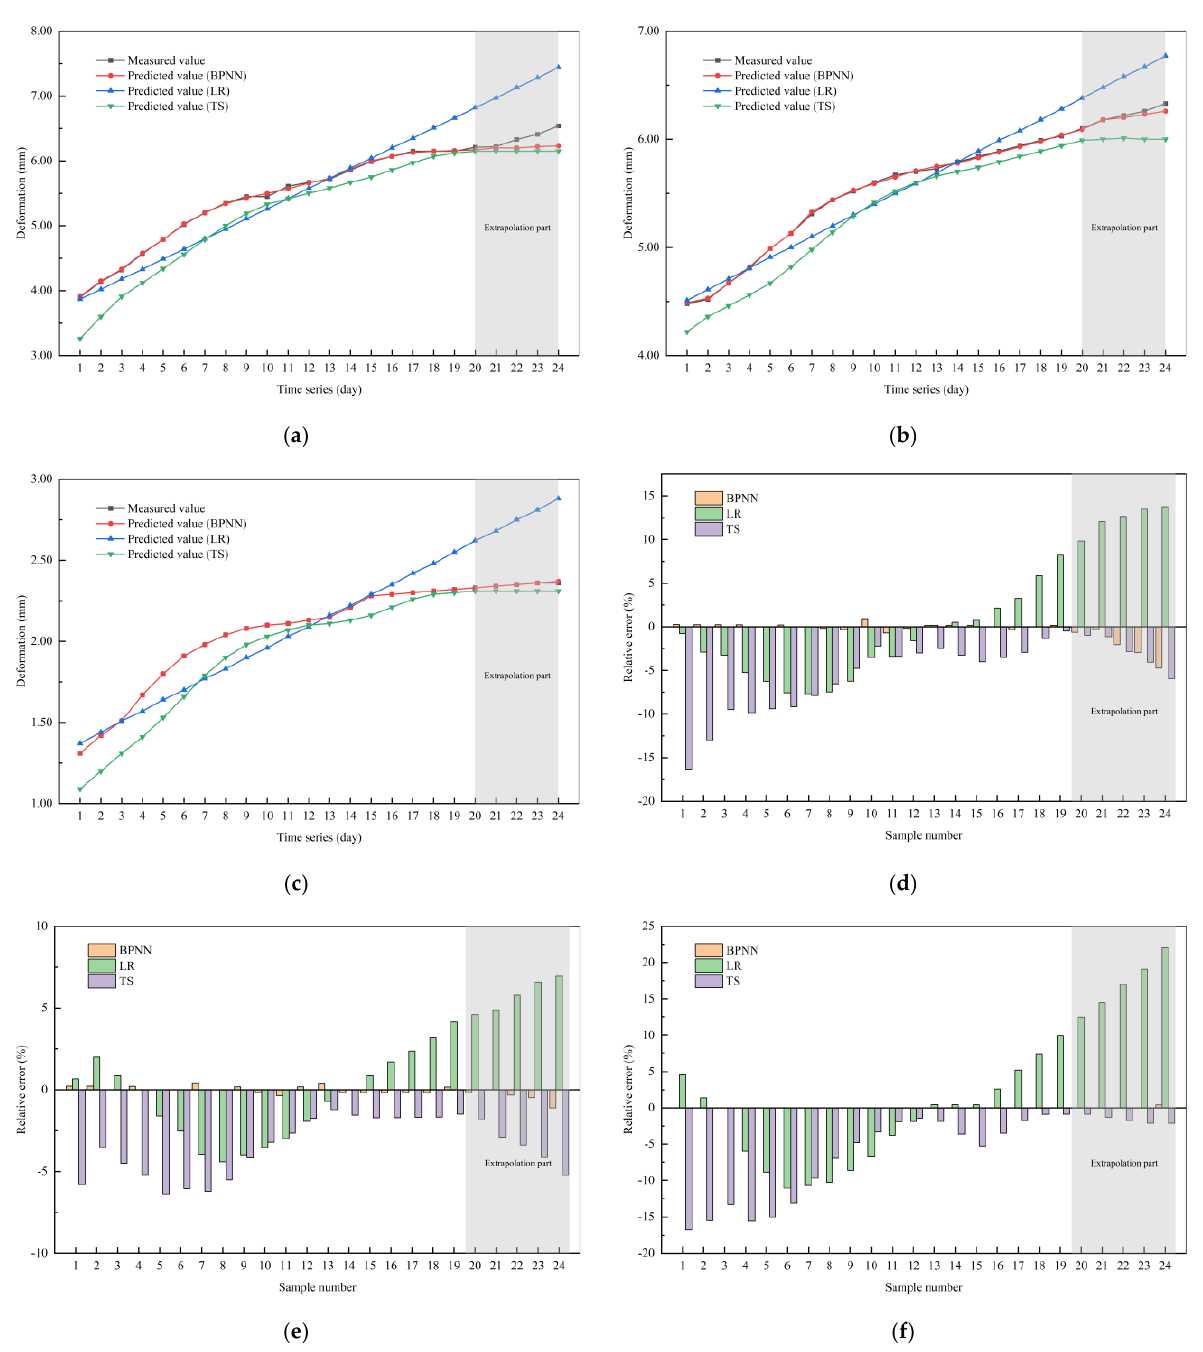
Figure 8. The comparison curves and errors between the predicted deformation and the measured value of points A, B and C. ( a ) The comparison curves between the predicted deformation and the measured value of point A; ( b ) the comparison curves between the predicted deformation and the measured value of point B; ( c ) the comparison curves between the predicted deformation and the measured value of point C; ( d ) the errors between the predicted deformation and the measured value of points A; ( e ) the errors between the predicted deformation and the measured value of points B; ( f ) the errors between the predicted deformation and the measured value of points